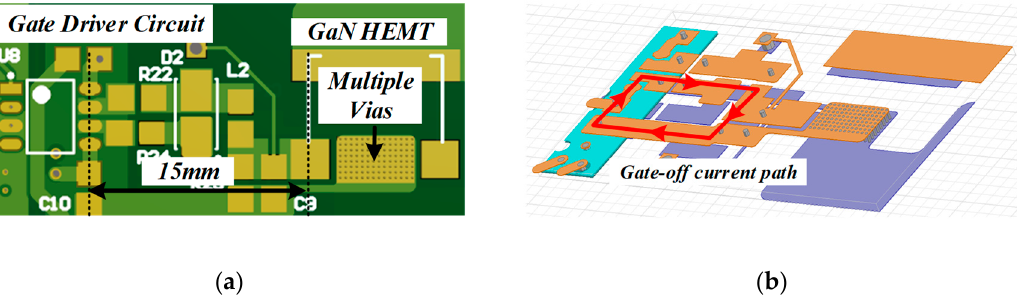
Figure 4. ( a ) Gate driver circuit of fabricated printed circuit board (PCB); ( b ) ANSYS Q3D software view.